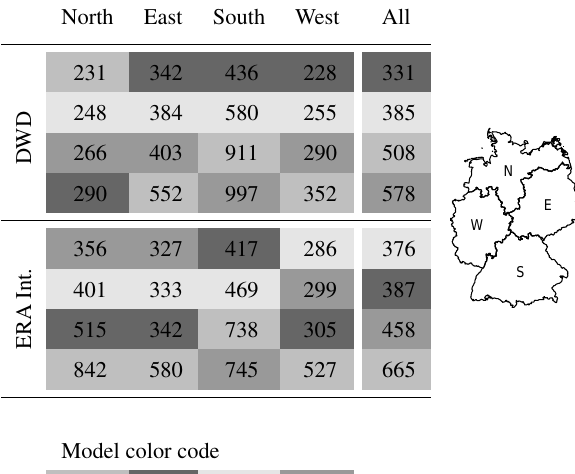
Table 2. Spatial averages of the coefficient of variation (RMSE) for each model. For ease of comparison, values are sorted in ascending order. The respective model is indicated by the color code. The spatial extent is defined by the four geographic regions (north, east, south, west) depicted in the map inset.